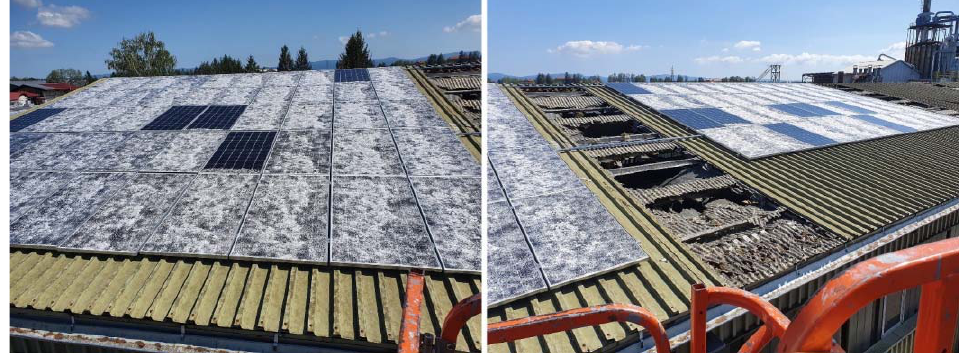
Figure 2. Photographs of damaged PV arrays of the studied test site.